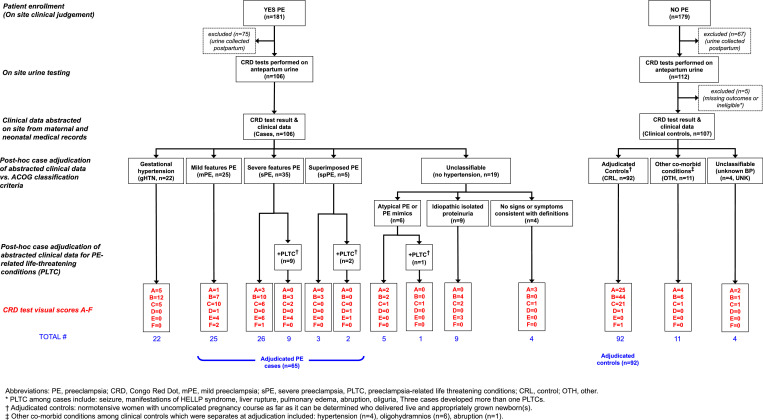
Study flowchart: Mexico.